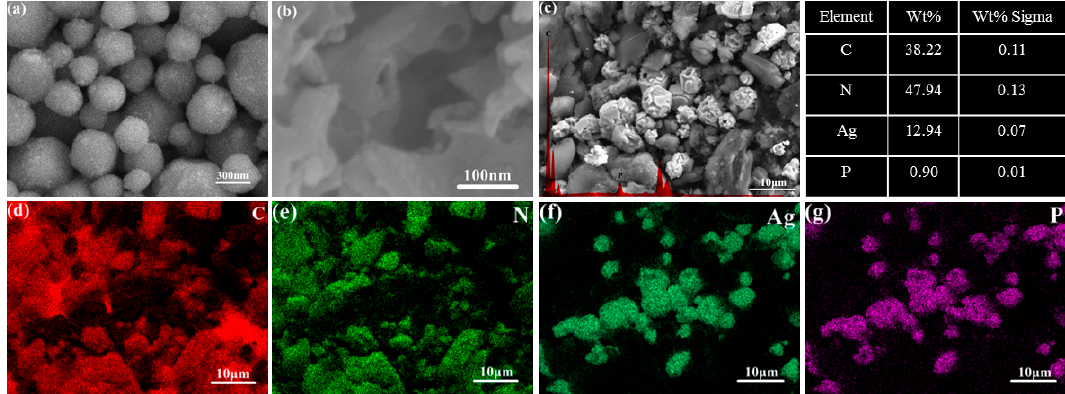
Figure 2. SEM images of: Ag 3 PO 4 ( a ); g-C 3 N 4 ( b ); and AgCN (inset with element ratio) ( c ); and corresponding element mapping of AgCN composite ( d – g ).